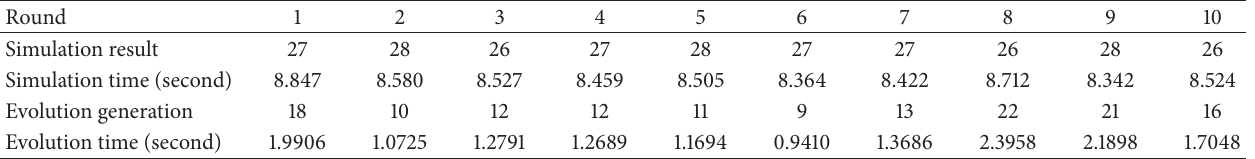
Table 8: The simulation results of ten rounds of experiments of IQGA.